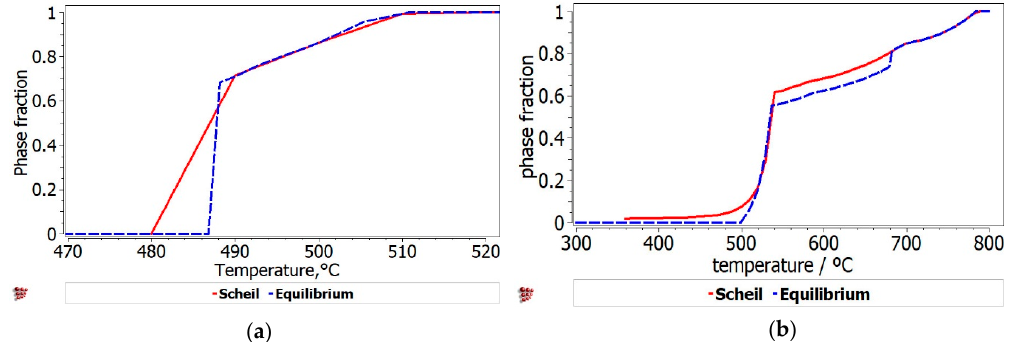
Figure 9. Equilibrium and Scheil–Gulliver liquidus solidification curves for the: ( a ) Al 3.4 Cu 0.5 Si 0.2 Zn 0.5 Mg 0.2 alloy and ( b ) Al 3 Mn 0.2 Zn 0.3 Mg 0.7 Si 0.8 alloy.